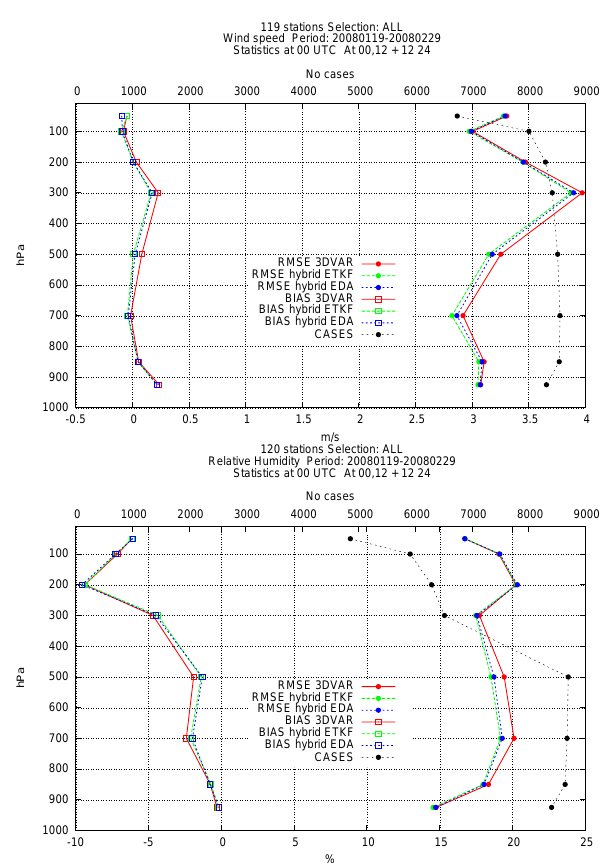
Fig. 17. Ensemble perturbation spectra in ensemble space calcu- lated from differences between ensemble members and ensem- ble control in observation points. 22 January 2008 12 UTC +06h. 3D-Var hybrid with EDA perturbations ( eda hybrid 1 , red curve), 3D-Var hybrid with ETKF perturbations ( 3 dvar hybrid 1 , green curve), 4D-Var hybrid with ETKF perturbations ( 4 dvar hybrid 1 , blue curve) and 4D-Var hybrid with ETKF perturbations including also a lagged valid time ensemble ( 4 dvar hybrid 2 , pink curve).